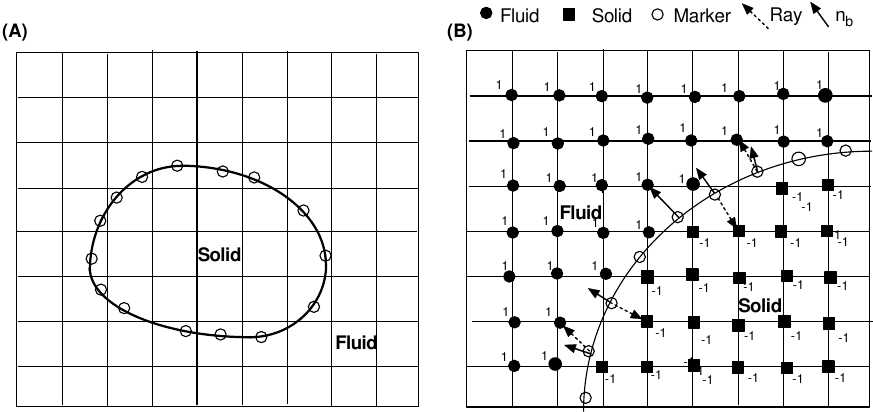
Figure 1. ( A ) An arbitrary object immersed in Cartesian coordinates. ( B ) A ray tracing algorithm is utilized in the immersed boundary algorithm [45,46] to identify solid and fluid grid points in the computational